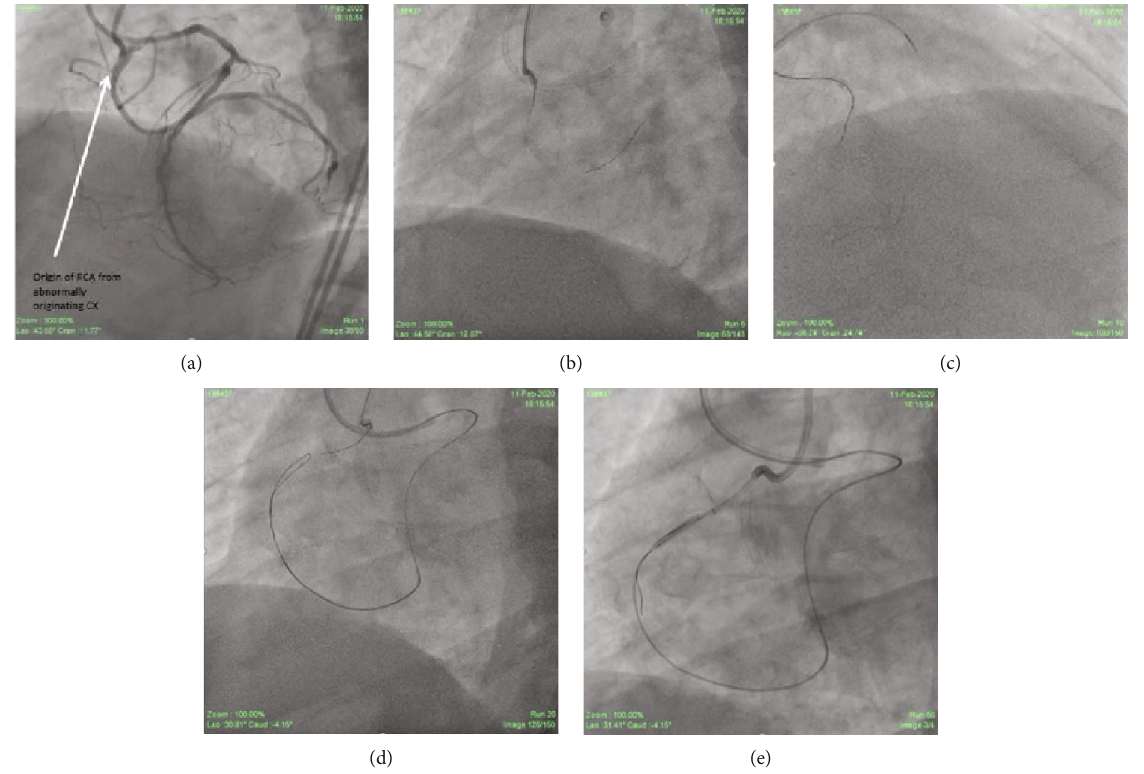
Figure 1: (a) Retrogradely fi lling abnormal RCA originating from abnormally originating CX. (b) POT done in CX stent. (c) Sion blue and Corsair crossed retrogradely. (d) Knuckle pilot wire reaching proximal RCA subintimaly. (e) Guideliner assisted creation of common space